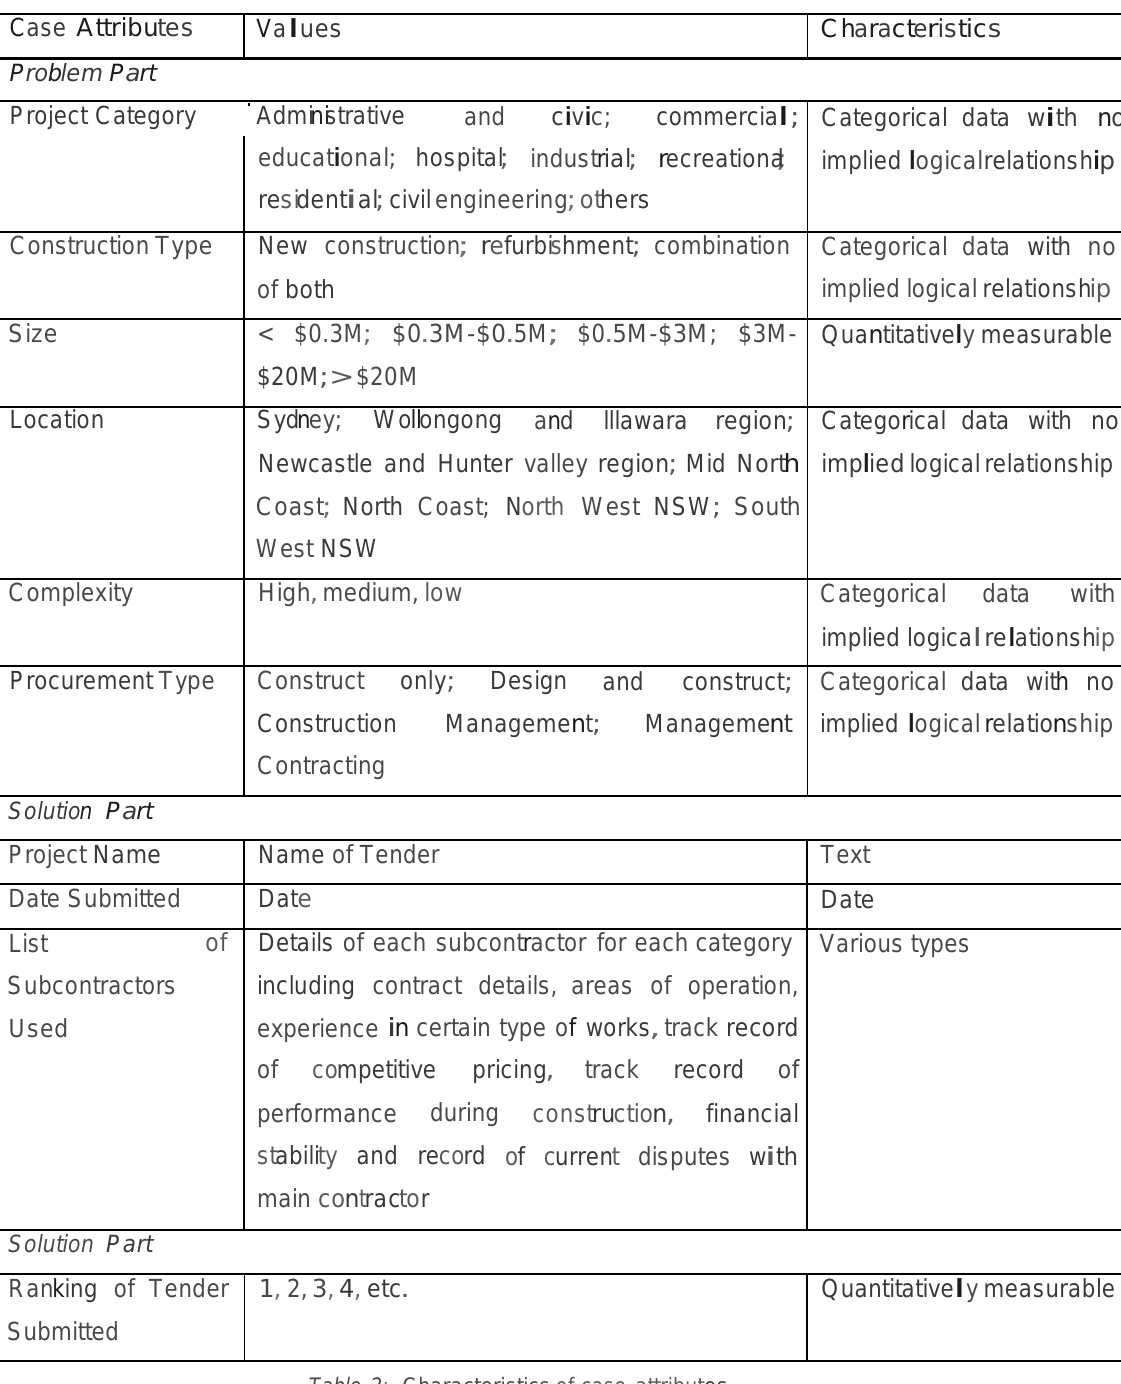
Table 2: Characteristics of case